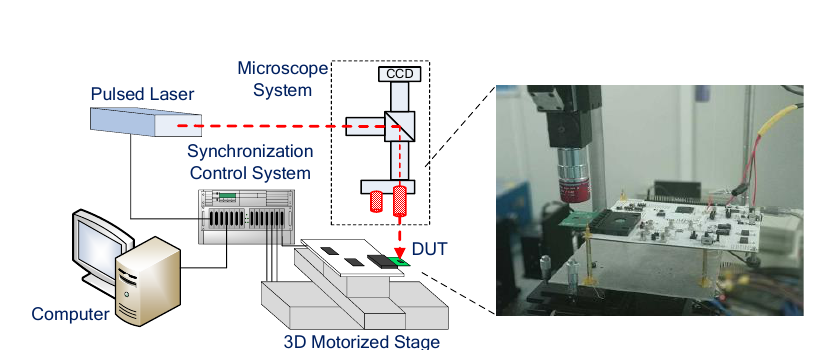
Figure 2: Schematic of pulsed laser facility for our persistent fault